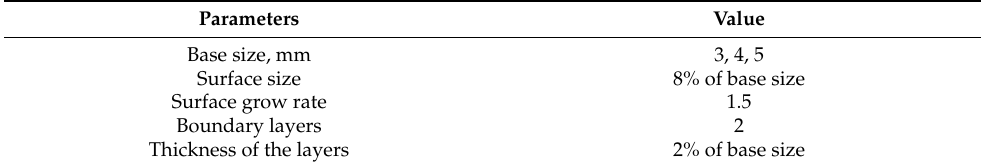
Table 4. Control parameters for grid generation of surface and volume